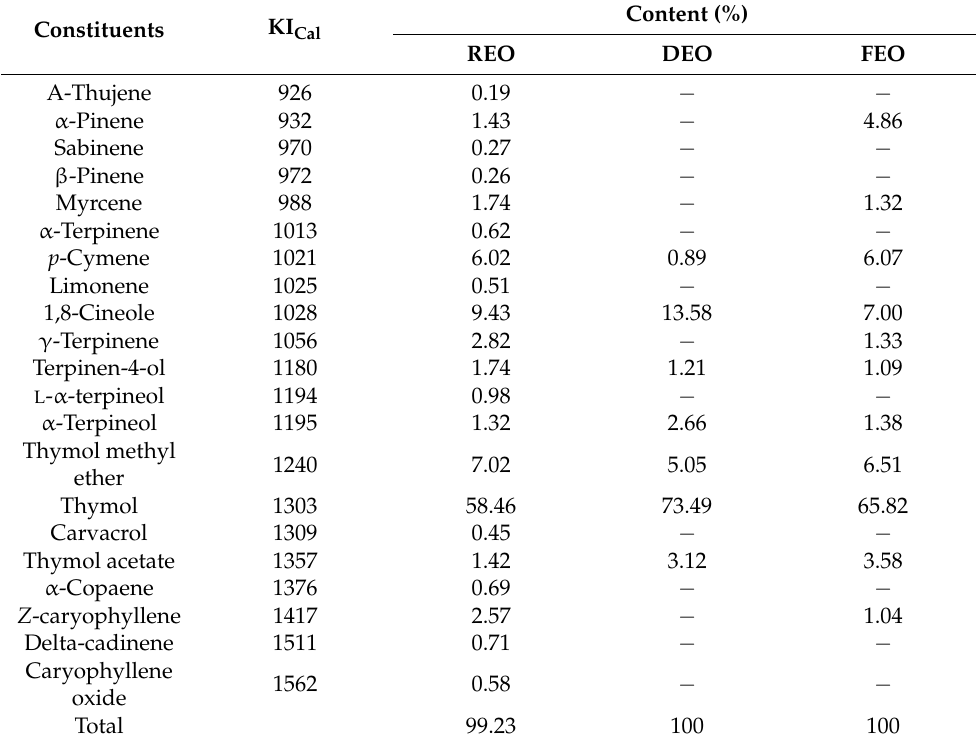
Table 1. Chemical constituents of the essential oils of the leaves of L . grata .